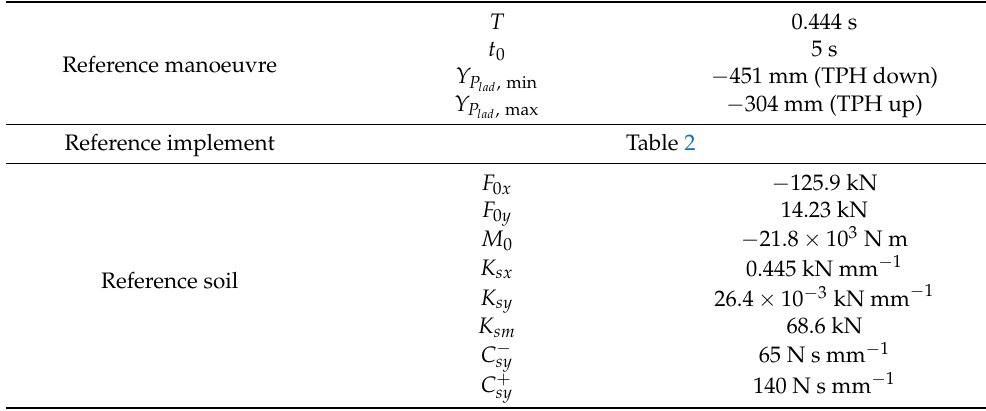
Table 3. Parameters used in the simulations.